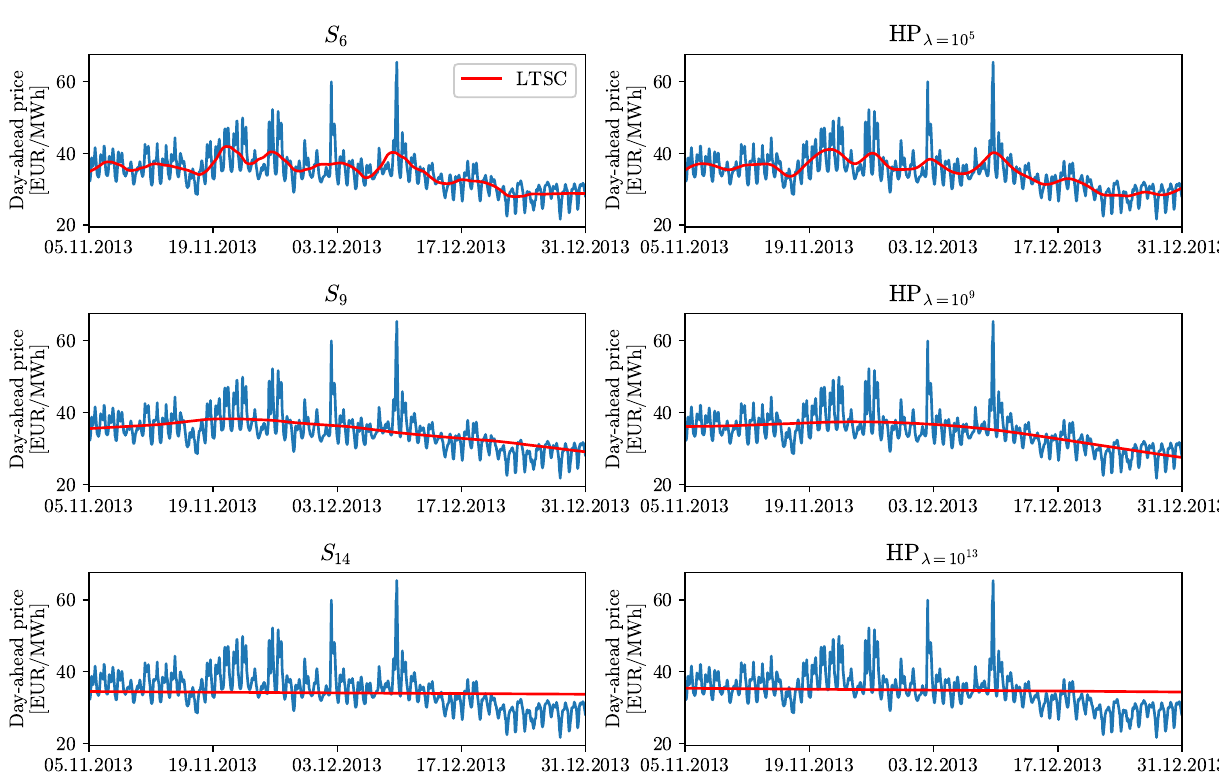
Figure 3. Illustration of the long-term trend-seasonal component (LTSC) based on wavelets S 6 , S 9 , and S 14 ( left column ) and HP filters with λ = 10 5 ,10 9 , and 10 13 ( right column ) fitted to Nord Pool prices in the initial calibration window, see Figure 1. Only the last eight weeks are